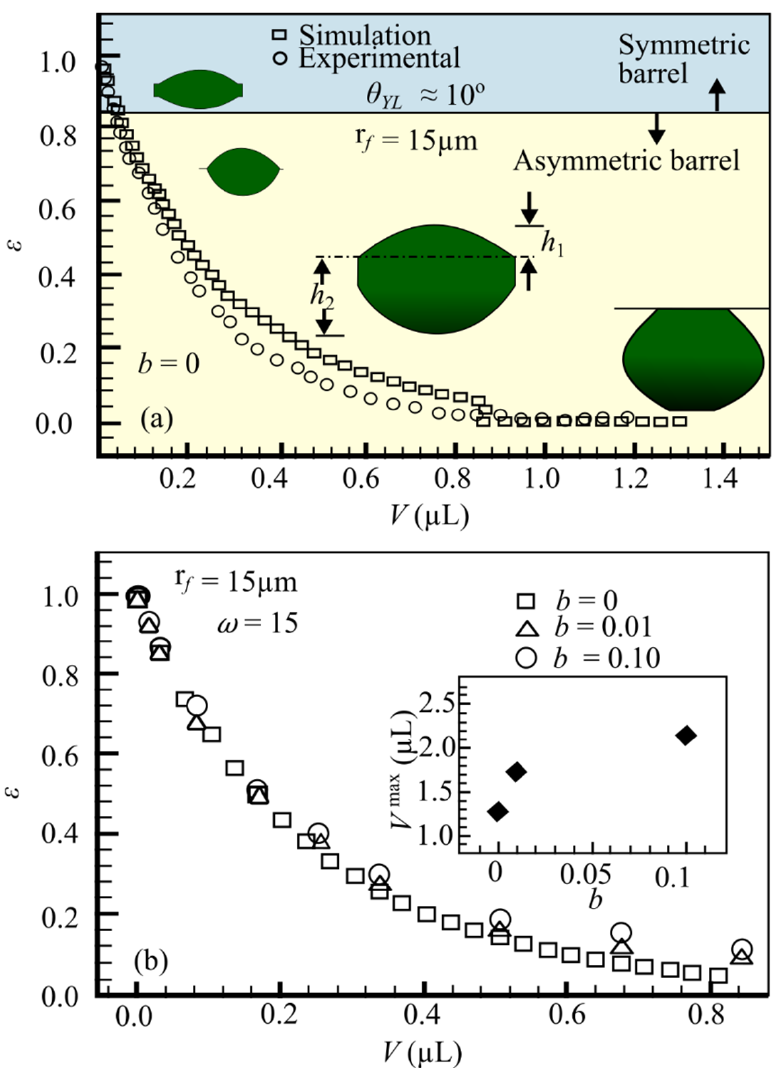
Figure 9. The droplet volume of ultra-low sulfur diesel (ULSD) droplets on smooth PP fibers is compared to the asymmetry factors from experiments and computer simulations ( a ). The asymmetry factor for the radius is indicated in ( b ). On the same fibers but with varying roughness amplitudes, the inset indicates the greatest droplet volume possible [59].